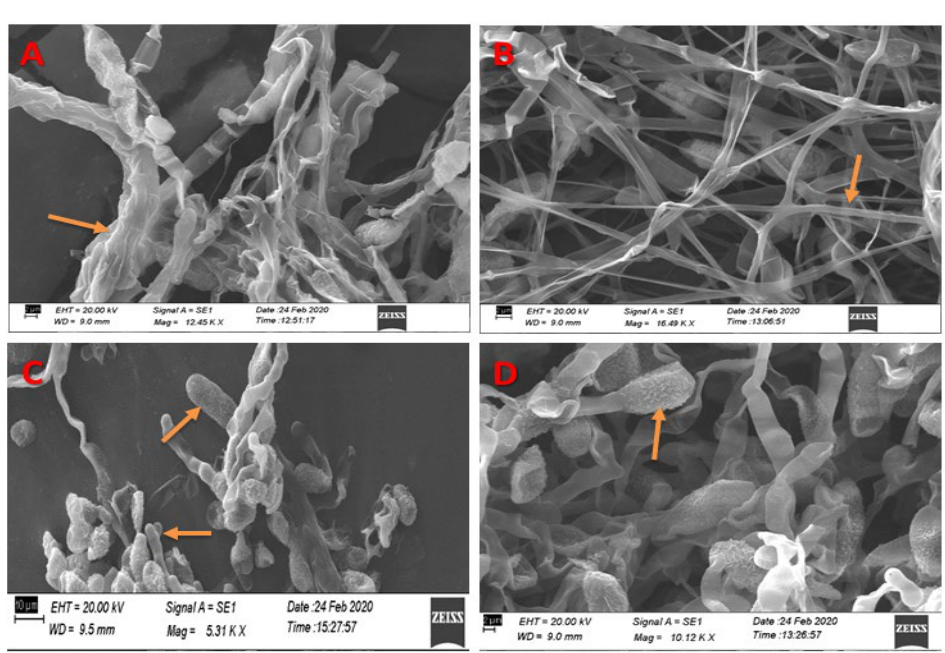
Fig. 3. SEM micrographs showing effects of A. sativum extract on the morphology and conidia of Alternaria solani. (A) Hyphae after treated with A. sativum extract (20%) observed collapsed hypha (arrow). (B) Hyphae of untreated treatment showing normal hypha (arrow). Bar = 2.0 µm. (C) Continuation in the sentence shrinking and an arrow shows the small rings (septa) formation on conidia. (D) In control treatment showing no